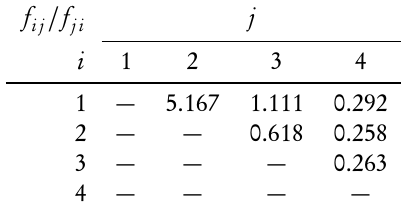
The values of f